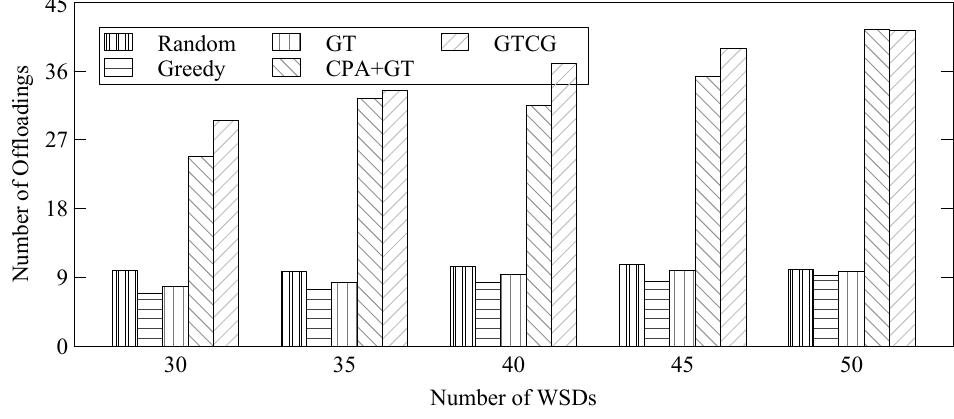
Figure 10. Average Number of Offloadings for Uneven WSD